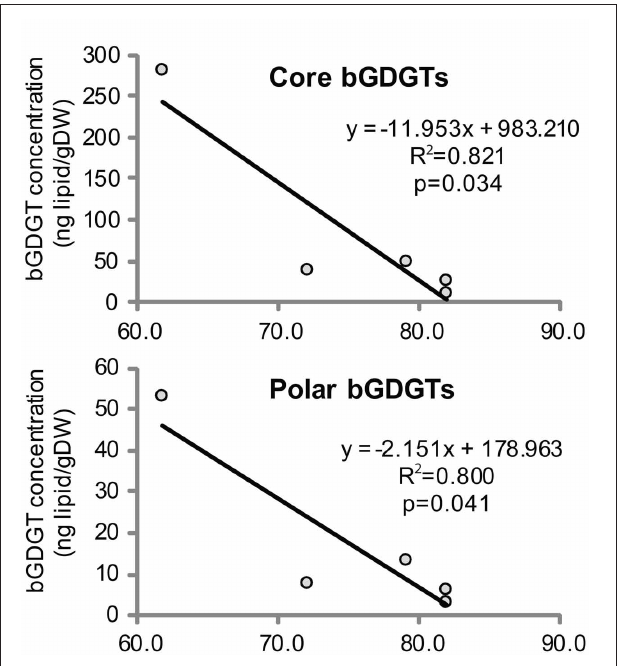
FIGURE 2 | Regression analyses indicated negative, linear relationships between the absolute abundance of C- and hydrolysis-derived P- bGDGTs in hot spring sediments and temperature (sig. < 0.05). bGDGT abundance was normalized to g dry mass of